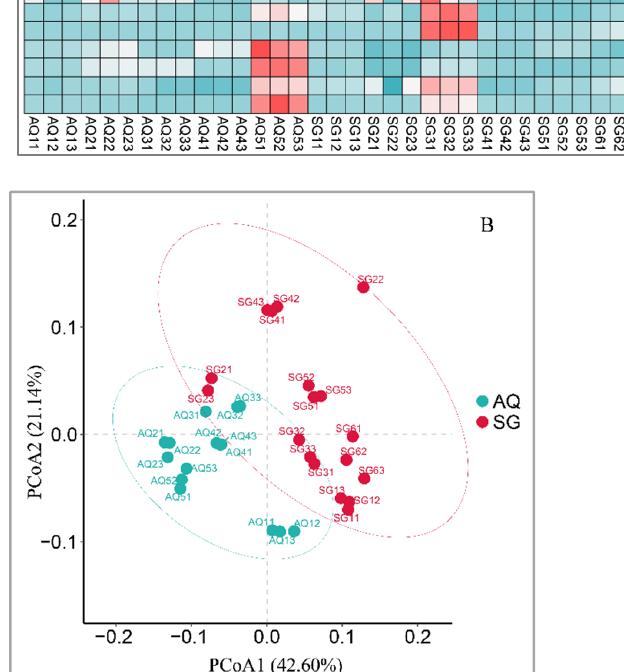
Figure 2. Heatmap ( A ) and PCoA ( B ) based on the Bray–Curtis index of bacterial communities in different greenhouse